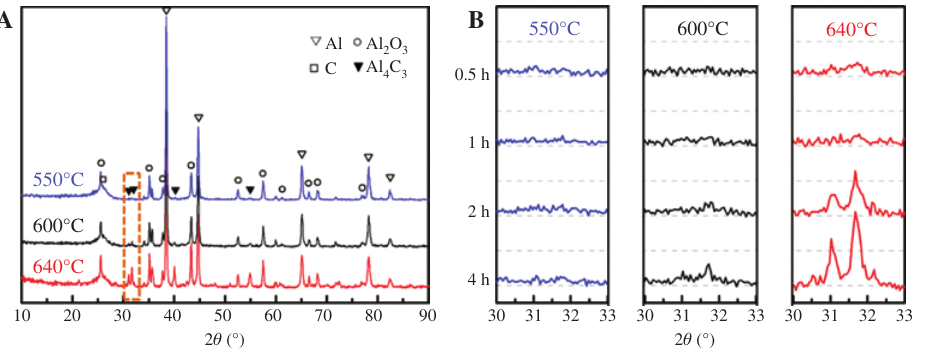
/Al composites after heat treated. f